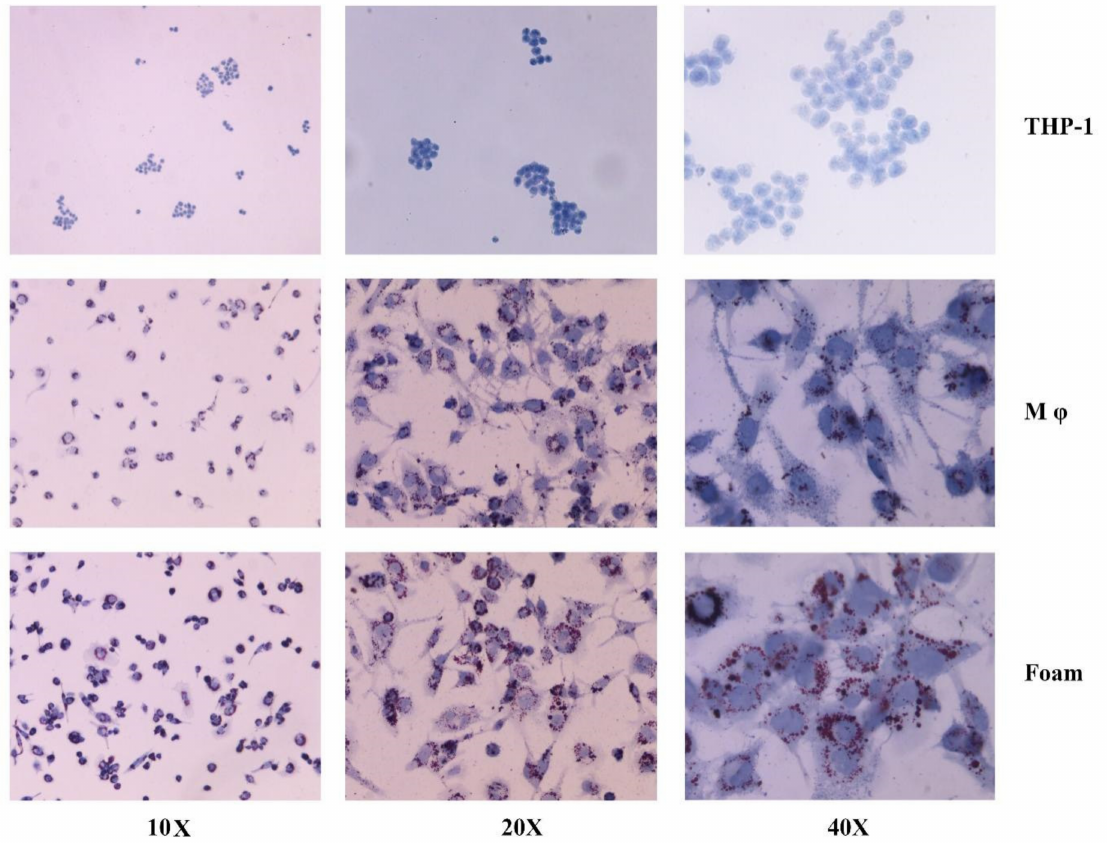
Figure 2. The microphotography of Oil Red O staining: THP-1; macrophage cells (M ϕ ); and foam